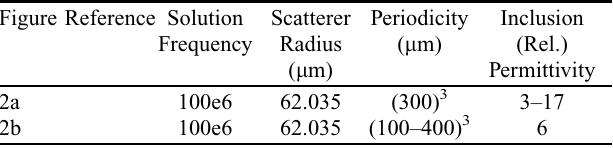
Table 1. Specifications of the simulated geometries. The superscript 3 indicates the periodicity in the three orthogonal directions. Host relative permittivity is set to one in each